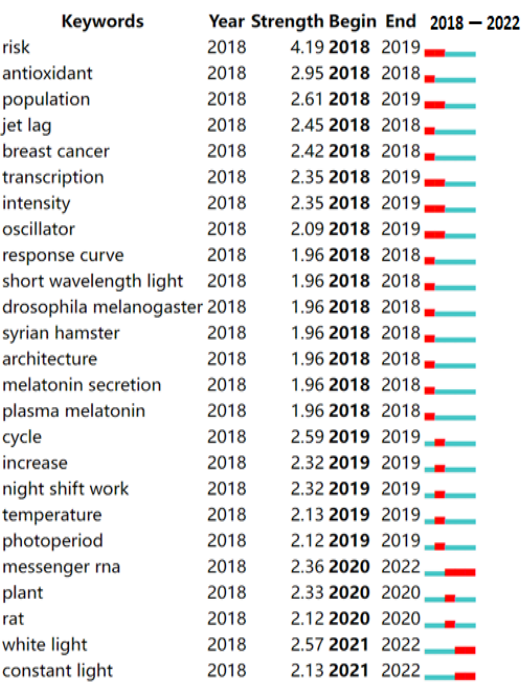
Figure 4. Top 25 keywords with strongest citation bursts (red line represents the year of the citation